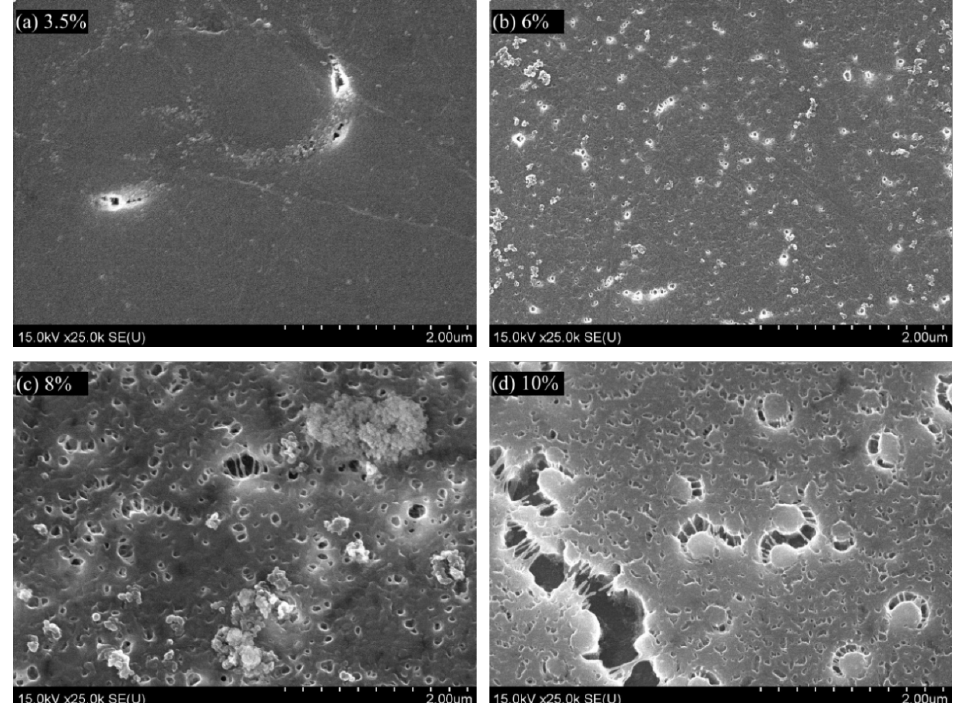
Figure 4. SEM images of PPX+Ag composite coating with ( a ) 3.5%, ( b ) 6%, ( c ) 8%, ( d ) 10% volume concentration of